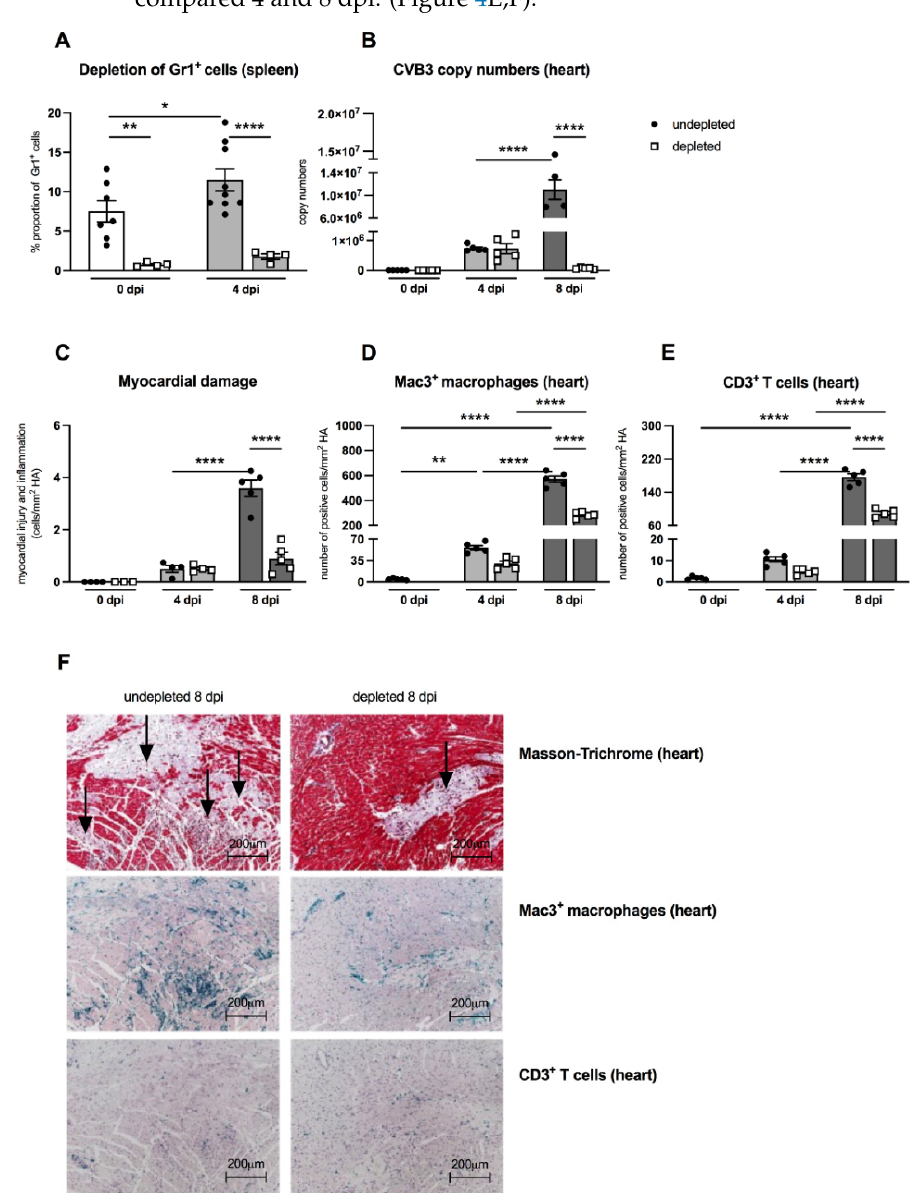
Figure 3. Gr-1 depletion decreases viral load, damage, and inflammation in the heart of CVB3-infected A.BY/SnJ mice. ( A ) Following treatment of CVB3-infected mice with anti-Ly6G (RB6-8C5), spleen cells were stained at 0 dpi and 4 dpi with an anti-Gr-1-FITC antibody and analyzed via flow cytometry. The y-axis displays the percentual proportion of 20,000 measured splenic cells (with n = 4–7 for 0 dpi and n = 4–9 for 4 dpi). ( B ) Next, hearts from Gr-1-depleted and non-depleted mice were analyzed regarding CVB3 copy number by quantitative real-time PCR at 0 dpi, 4 dpi, and 8 dpi (with n = 5 for 0 dpi, n = 5 for 4 dpi, and n = 4–5 for 8 dpi). ( C ) In addition, myocardial damage was quantitatively determined on hematoxylin-eosin (H/E) stained tissue sections at the respective time points (with n = 3–4 for 0 dpi, n = 4 for 4 dpi, and n = 5 for 8 dpi). Additionally, Gr-1 depletion decreases Mac3 + macrophages and CD3 + T lymphocytes in the heart of CVB3-infected A.BY/SnJ mice. After depletion of Gr-1 + cells with anti-Ly6G (RB6-8C5), the number of ( D ) Mac3 + macrophages and ( E ) CD3 + T cells/ mm 2 heart area (HA) was quantified at 0, 4, and 8 dpi, using the respective immunohistological stainings. ( F ) Representative pictures display Masson-Trichrome staining (upper panel, arrow indicate damage), the immunohistological staining of Mac3 + cells (middle panel), and the staining of CD3 + cells (lower panel) of non-depleted and depleted animals at 8 dpi (magnification × 100). All data are expressed as mean ± SEM and were analyzed with One-way ANOVA or Kruskal-Wallis test (* p < 0.05, ** p < 0.01, **** p < 0.0001 with n = 5 for 0 dpi, n = 5 for 4 dpi, and n = 5 for 8 dpi).